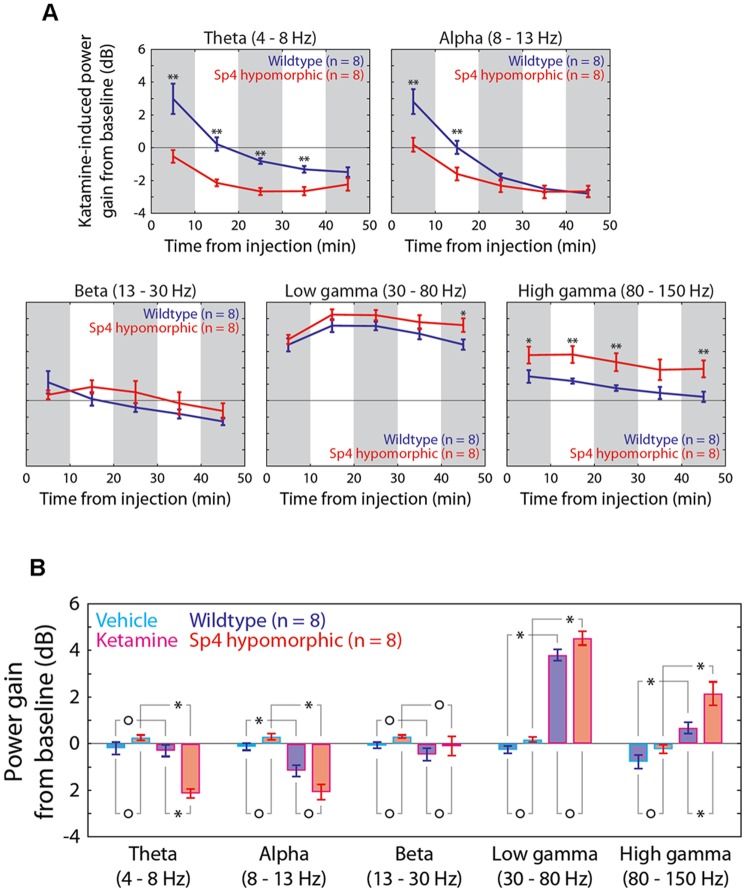
Time-course of ketamine-induced EEG power gain in various frequency ranges.(A) For 5 frequency ranges, i.e. theta, alpha, beta, low gamma and high gamma, EEG powers were analyzed in 10-minute bins subsequent to intraperitoneal injection of 50 mg/kg ketamine or saline vehicle. Illustrated are means and SEMs of population data for wildtype (n = 8) and Sp4 hypomorphic (n = 8) mice. Significant results of 2-sample 2-tail Z-tests are indicated by asterisks (* p<0.05; ** p<0.01). (B) Vehicle- and ketamine-induced gain of power from baseline in various frequency bands for the whole dataset. Error bars represent SEM. Results of 2-sample 2-tail Z-tests were shown above and below the bar plots; Bonferroni correction for multiple hypothesis testing was used to adjust significance level (p = 0.05). Asterisks represent statistical significance and circles indicate no significance. A significant increase in high gamma, but not in low gamma, power was induced by ketamine versus by vehicle in Sp4 hypomorphic animals. In addition, a significant reduction in theta power was caused by ketamine only in Sp4 hypomorphic mice.